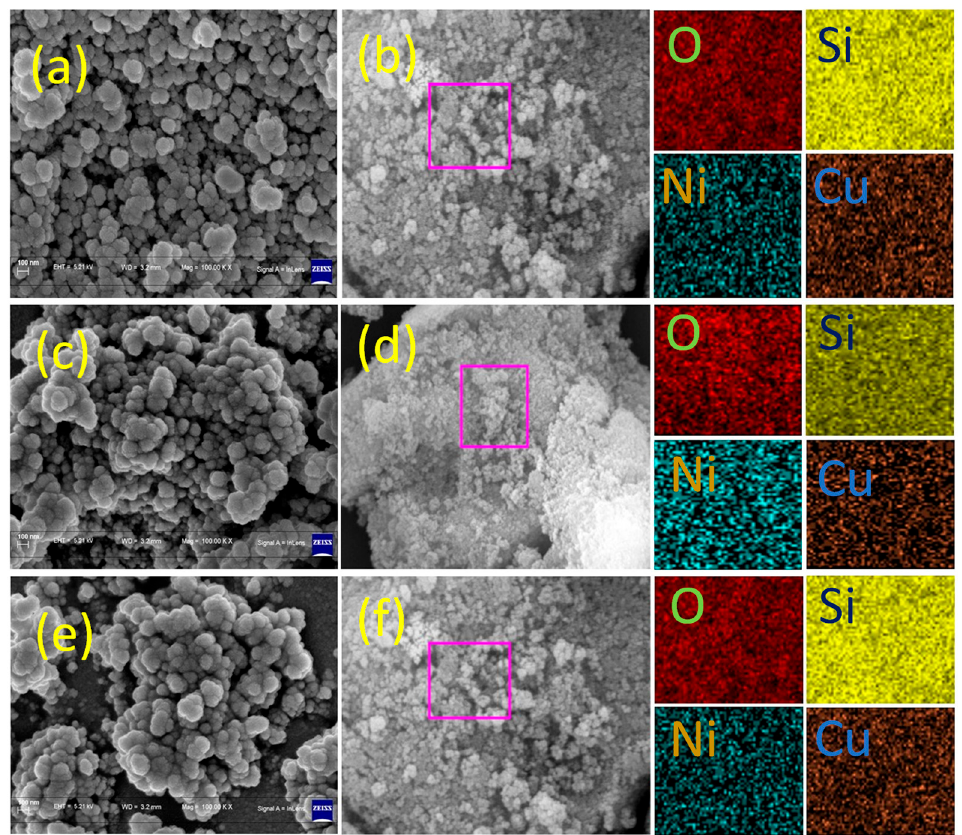
Figure 3. SEM-EDX of Ni 15 Cu 5 /m-SiO 2 ( a , b ), Ni 10 Cu 10 /m-SiO 2 ( c , d ), Ni 5 Cu 15 /m-SiO 2 ( e , f ) catalysts. The morphologies and structural details of the bimetallic Ni and Cu particles in the Ni 5 Cu 15 /m-SiO 2 catalyst was further studied by TEM (Figure 4a). It shows Ni and Cu par- ticles are well dispersed, and the aggregated particles are not observed even after being pretreated at 500 °C. HR-TEM images of Ni 5 Cu 15 /m-SiO 2 sample show particles of ~20 nm and ~5 nm. Figure 4e shows a lattice fringe in the high-resolution HR-TEM images and d- spacing value of ~0.21 nm, corresponding to the (111) plane of the Ni-Cu alloy phase [35].